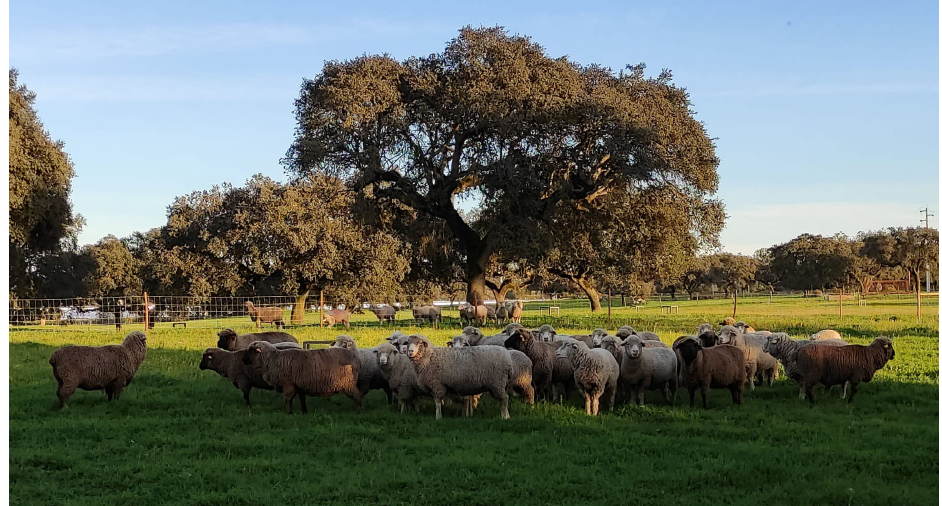
Figure 3. White Merino and Black Merino sheep in a plot of the study area.